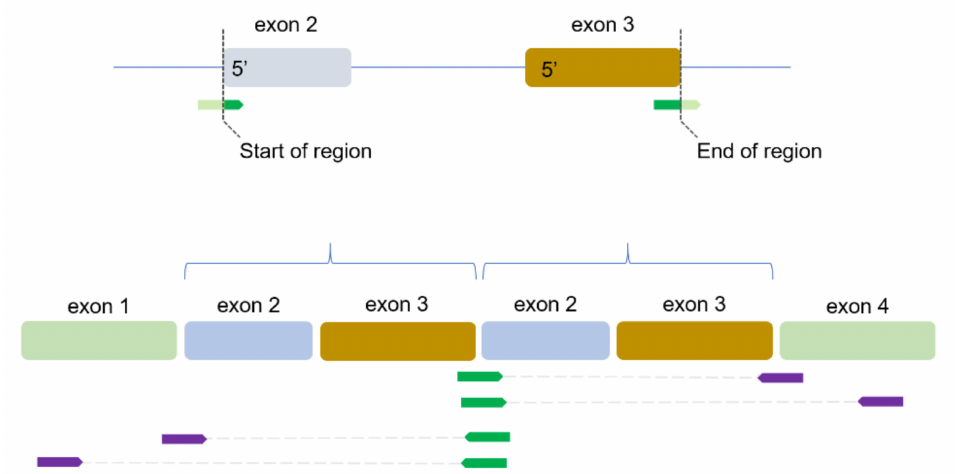
Figure 1. Identifying transcripts with a TD region. Top panel schematically shows how a junction read (green) would be located on the DNA reference. Introns are shown as horizontal lines. The 5 (cid:48) of the junction read maps to the 3 (cid:48) end of exon 3, while the remainder of the read maps to the 5 (cid:48) of exon 2. Since this is an unexpected orientation and depending on where the majority of the read maps, the read is annotated as mapping to one of the boundaries. The unmapped bases are annotated as soft clipped (S in the CIGAR score). The chromosomal positions of the junction ‘breakpoints’ are used as the start and end of a region. The bottom panel shows a TD of exon 2–3, with the read mates (purple) are partly or completely located outside the region defined by the chromosomal position of the junction read